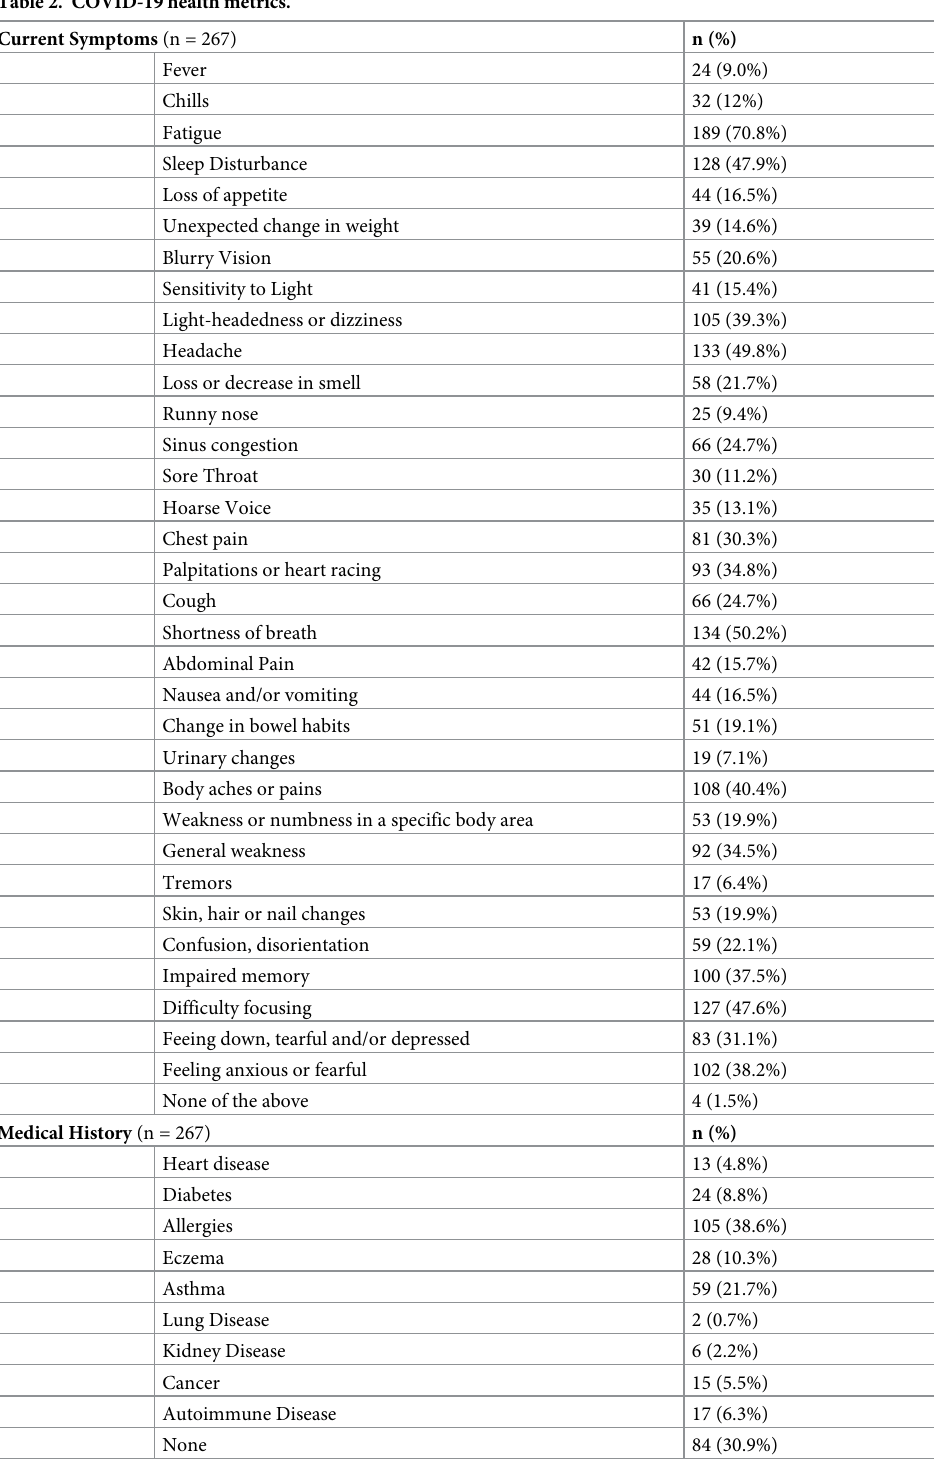
Table 2. COVID-19 health